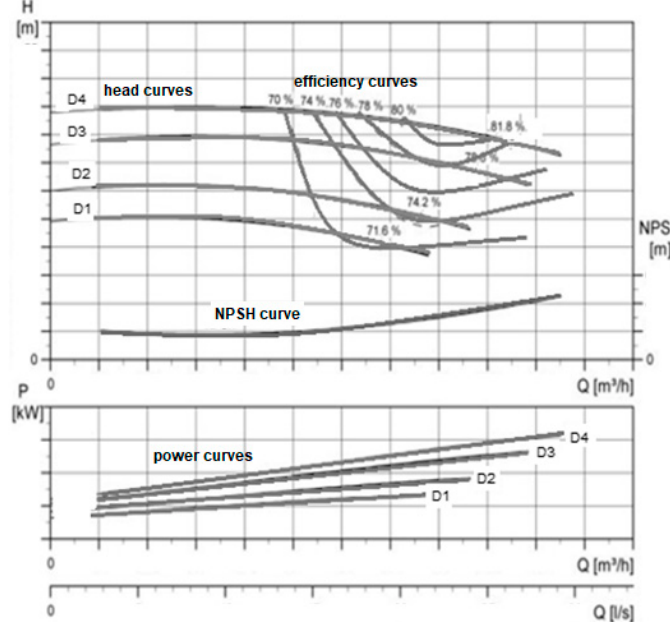
Figure 1. Typical pump characteristic curves: head, efficiency, NPSH and power curves.